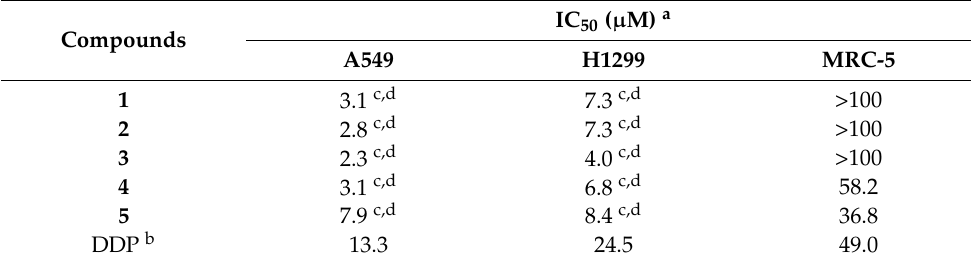
Table 3. Antiproliferative activity of compounds 1 – 5 .